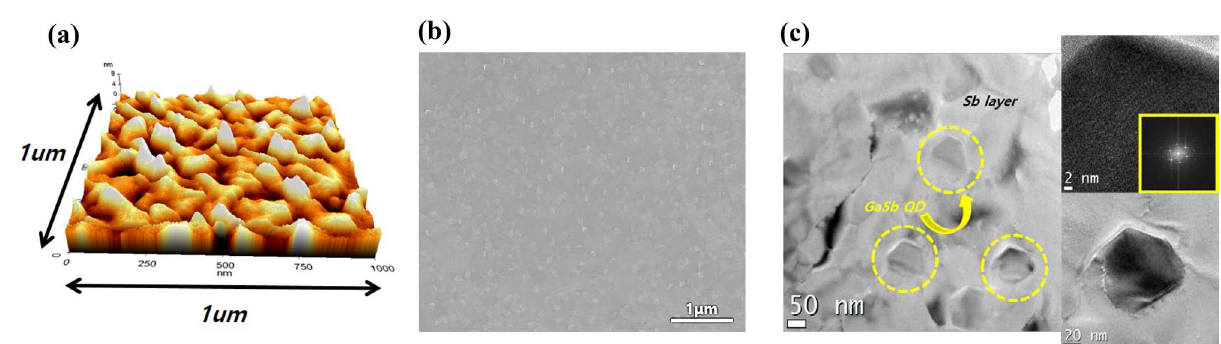
Figure 2. ( a ) AFM, ( b ) top-view SEM, and ( c ) TEM images of self-grown GaSb QD sample without GaAs capping layer to confirm the density and shape of GaSb